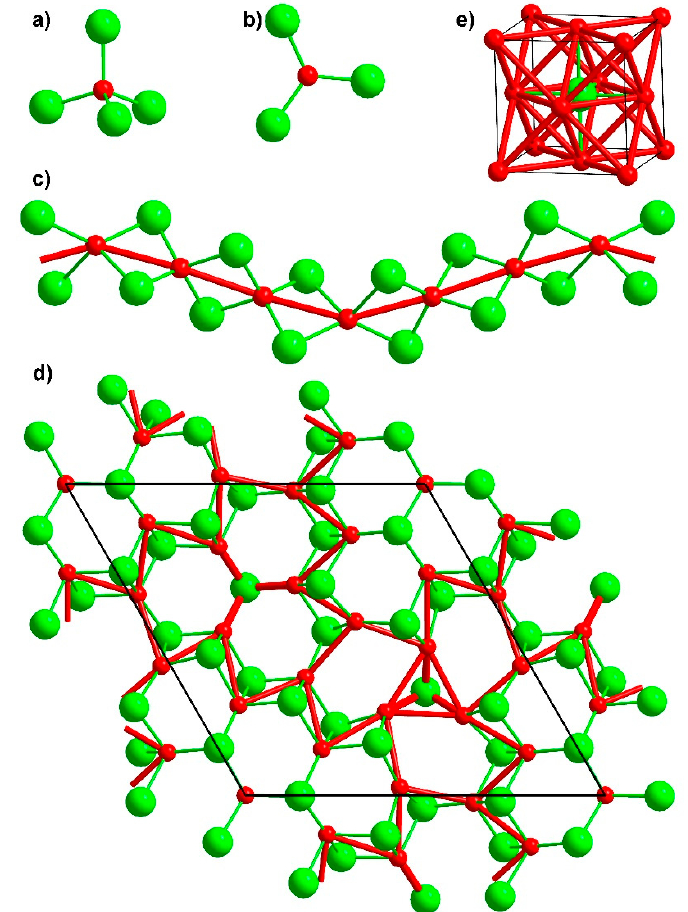
Figure 9. Mn–N and Mn–Mn interactions in nitridomanganates and manganes nitrides from 0D to